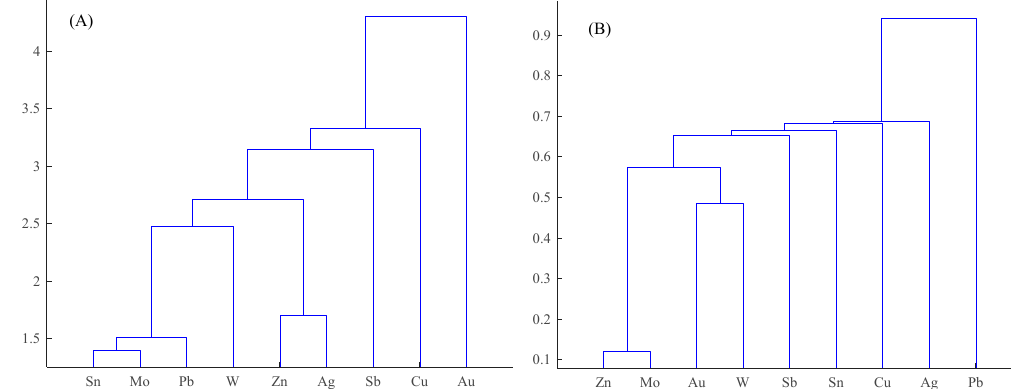
Figure 6. For hierarchical clustering of selected geochemical elements based on the frequency and spatial distribution parameters ( A ), and classical cluster analysis ( B ).